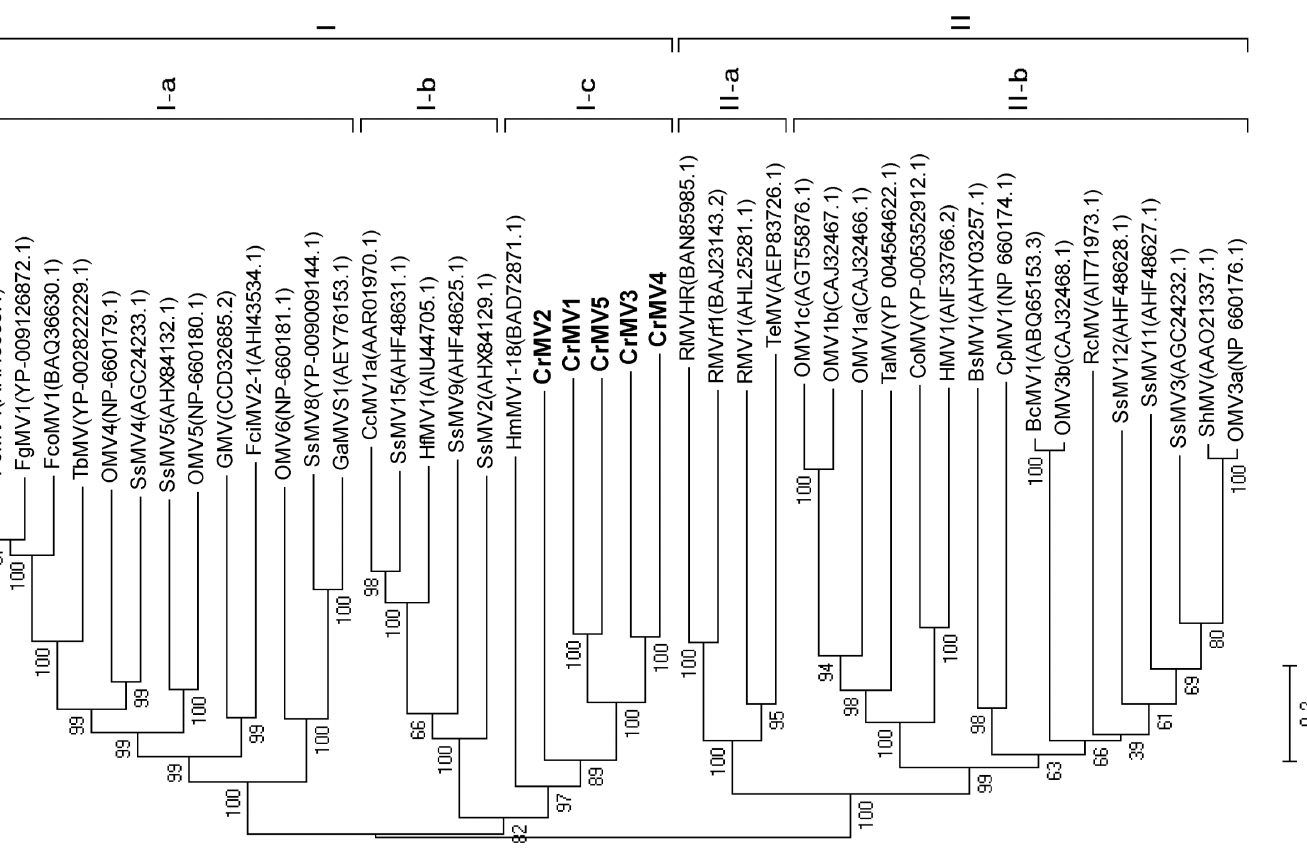
Fig 2. Phylogenetic tree analysis of the novel Cronartium ribicola mitoviruses (CrMV1 to CrMV5) and representative species (with GenBank accession numbers) of the genus Mitovirus . Neighbor-joining method was used for the phylogenetic analysis based on full-length alignment of RNA- dependent RNA polymerases (RdRp). Bootstrap support resulting from 1000 replicates is shown on the internodes and branch lengths correspond to genetic distance; the scale bar at lower left corresponds to a genetic distance of 0.2 for the RdRp